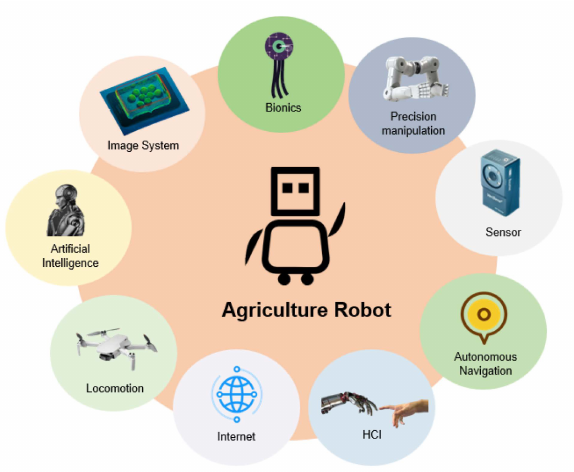
Figure 2. Core technologies involved in agricultural robotic